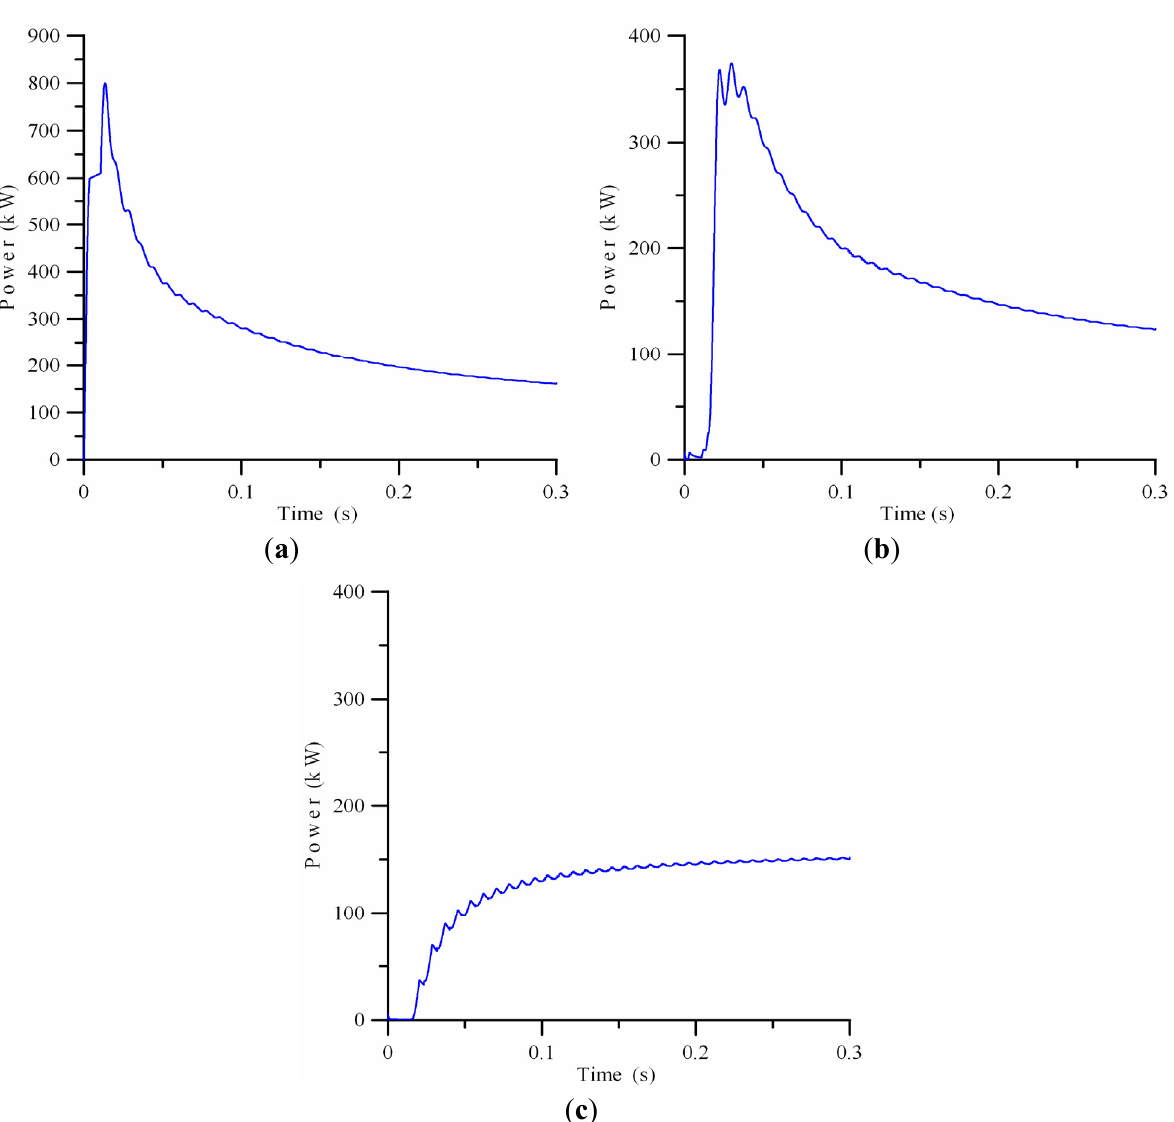
Figure 6. The instantaneous power waveforms of turn-on transients. ( a ) a 160 hp induction motor; ( b ) a 123 hp induction motor driven by variable-voltage drives; ( c ) a bank of loads supplied by a six-pulse thyristor rectifier for AC